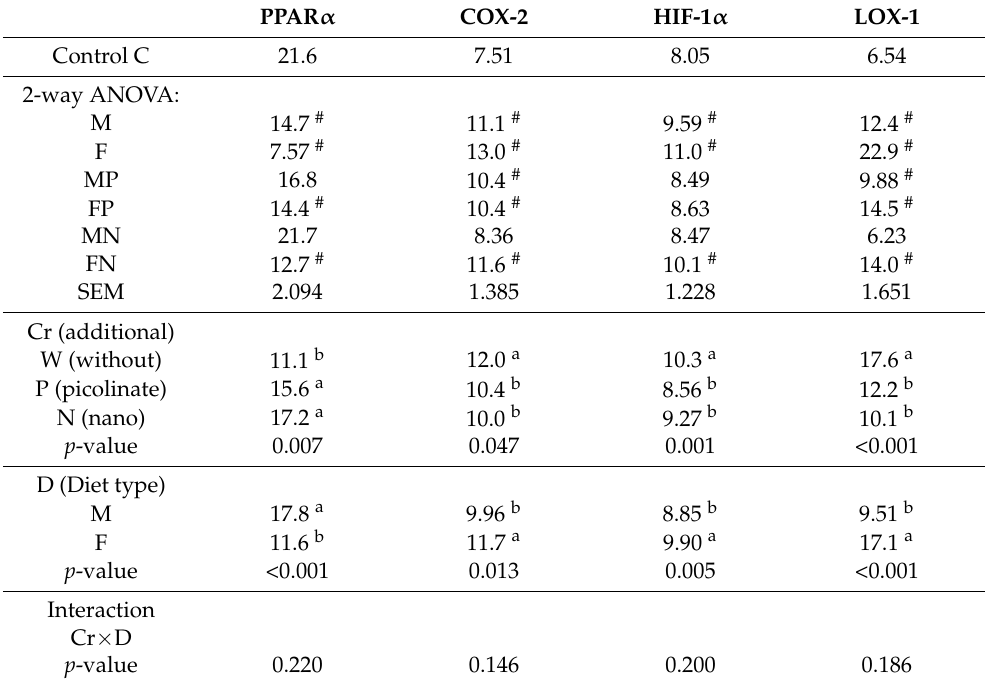
Table 3. Hepatic mRNA expression (relative expression normalized to β -actin × 10) of selected factors in the liver of rats fed experimental diets ( n = 12 per group)